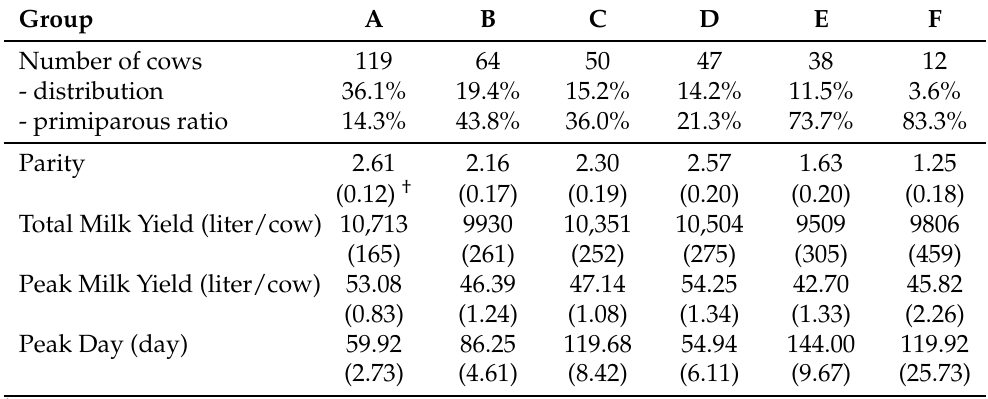
Table 2. Statistics for the LC